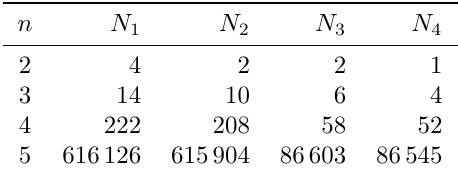
Table 2: Number of Boolean functions up to the extended bit permutation equivalence. N 1 , N 2 , N 3 , and N 4 denote the number of all Boolean functions, full-dependent Boolean functions, balanced Boolean functions, and full-dependent and balanced Boolean functions up to the equivalence,